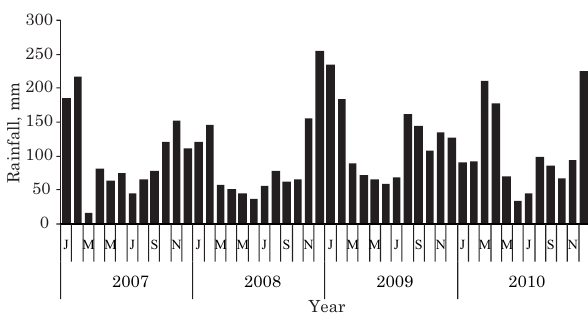
Figure 1. Monthly rainfall recorded in the region of Seropédica, RJ, between 2007 and